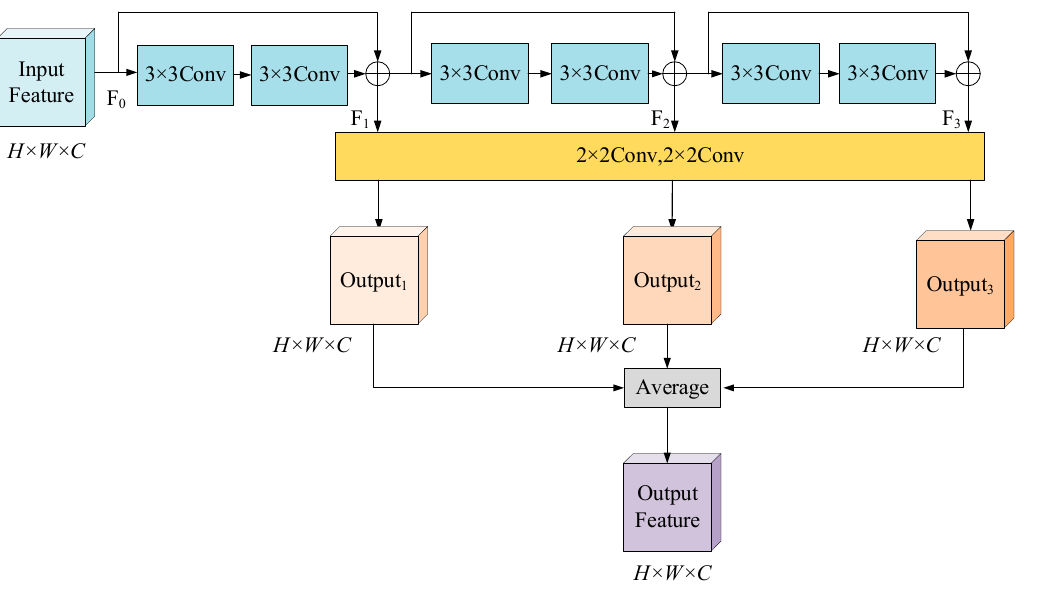
Figure 4. The detailed structure of an RRL Unit.